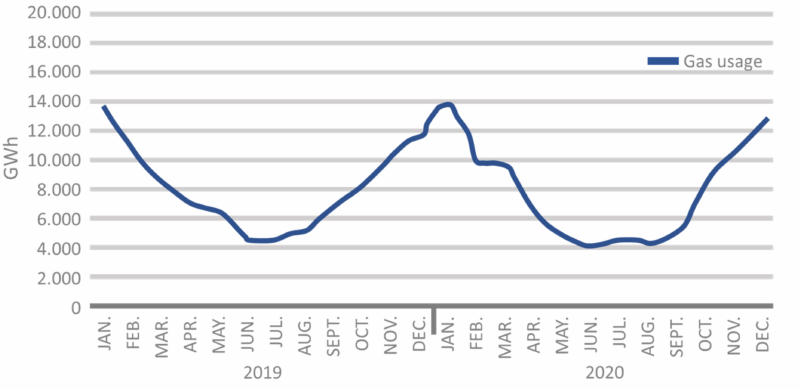
Figure 5. Gas consumption in Austria (adapted from [59] with permission from E-Control 2021).